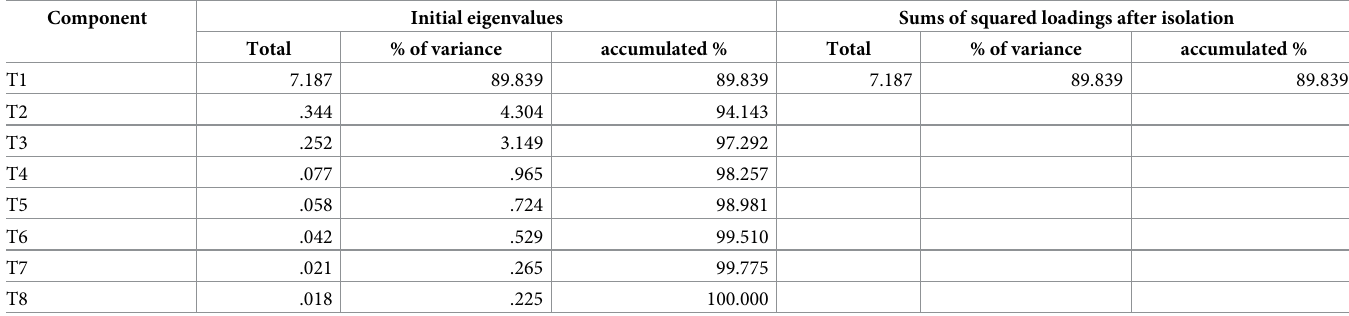
Table 7. Eigenvalues, variance explained by solution with 1 trust component.